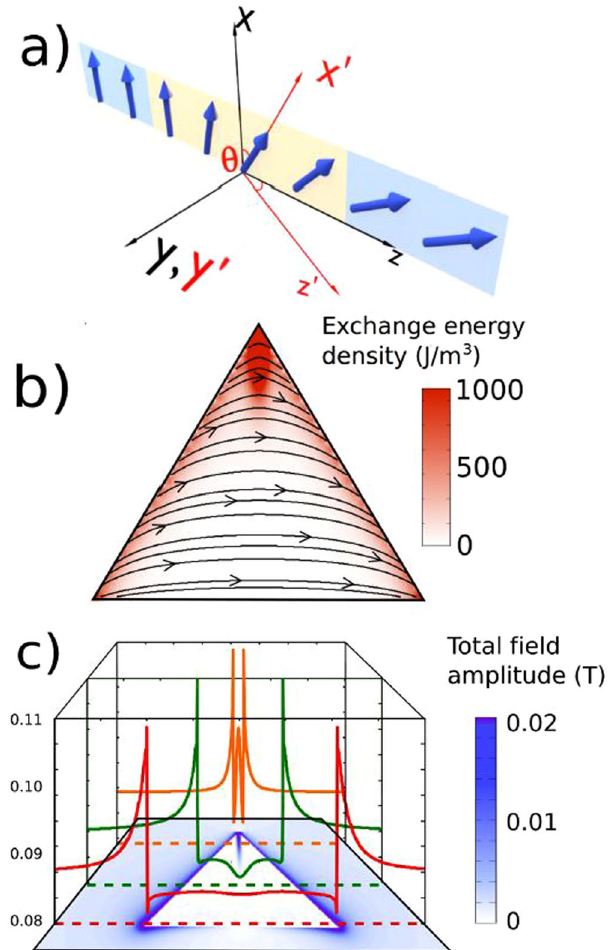
Figure 1. ( a ) Néel like domain wall. The yellow plane represents the domain wall, while the blue planes represent the domains separated by it. The xyz coordinate system is a reference system for the saturated state, whereas the x ′ y ′ z ′ system describes the orientation of each magnetic moment relative to the former. ( b ) Simulation of the exchange energy density profile (color scale) and magnetization distribution (streamlines and arrows) inside a 2 μ m thick dot. ( c ) Total magnetic field inside the same permalloy triangular dot. The color lines are cross sections of the field amplitude colormap, at the places marked with dashed lines. In both cases the applied field H = 1000 Oe is parallel to the triangle